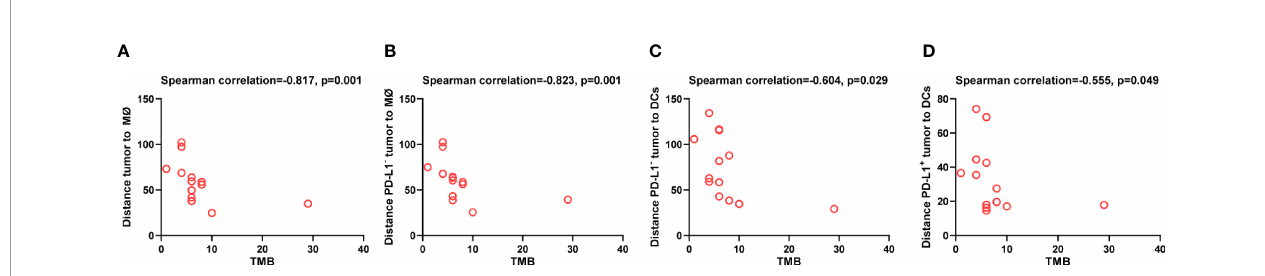
FIGURE 8 | Spatial distribution of dendritic cells and macrophages associated with tumor mutation burden. Spearman correlation analysis between tumor mutation burden and distance from (A) tumor cells to the nearest macrophages; (B) PD-L1 - tumor cells to the nearest macrophages; (C) PD-L1 - tumor cells to the nearest dendritic cells; (D) PD-L1 + tumor to the nearest dendritic cells. p ≤ 0.05, statistically signi